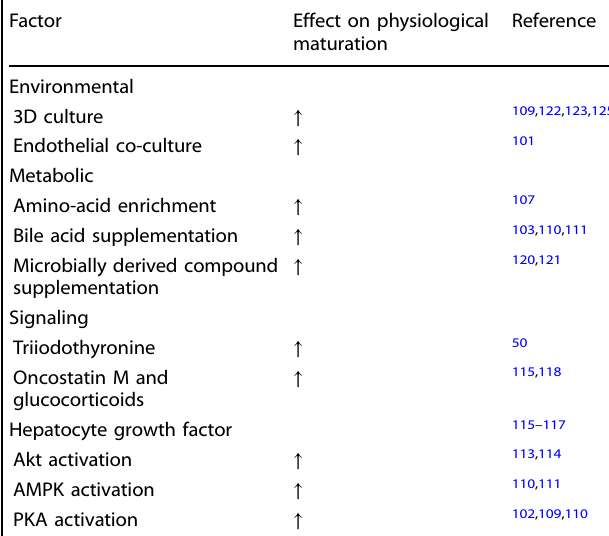
Table 3. Factors in fl uencing hepatic tissue